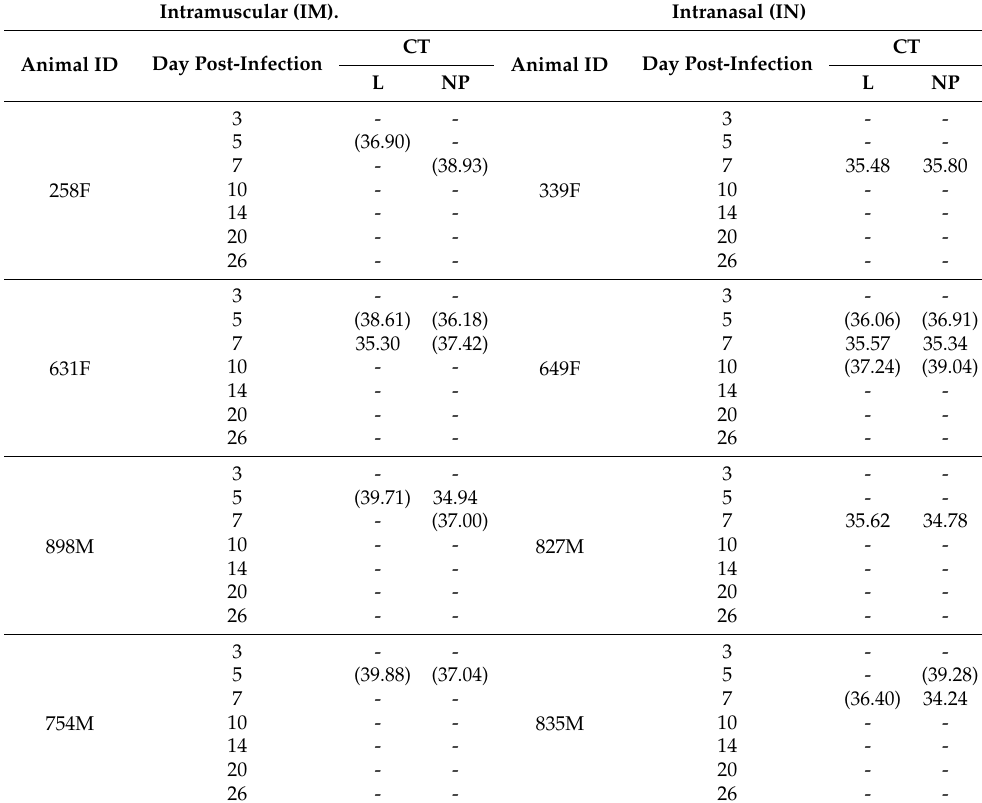
Table 1. Viral RNA load in blood of ferrets infected with TAFV.